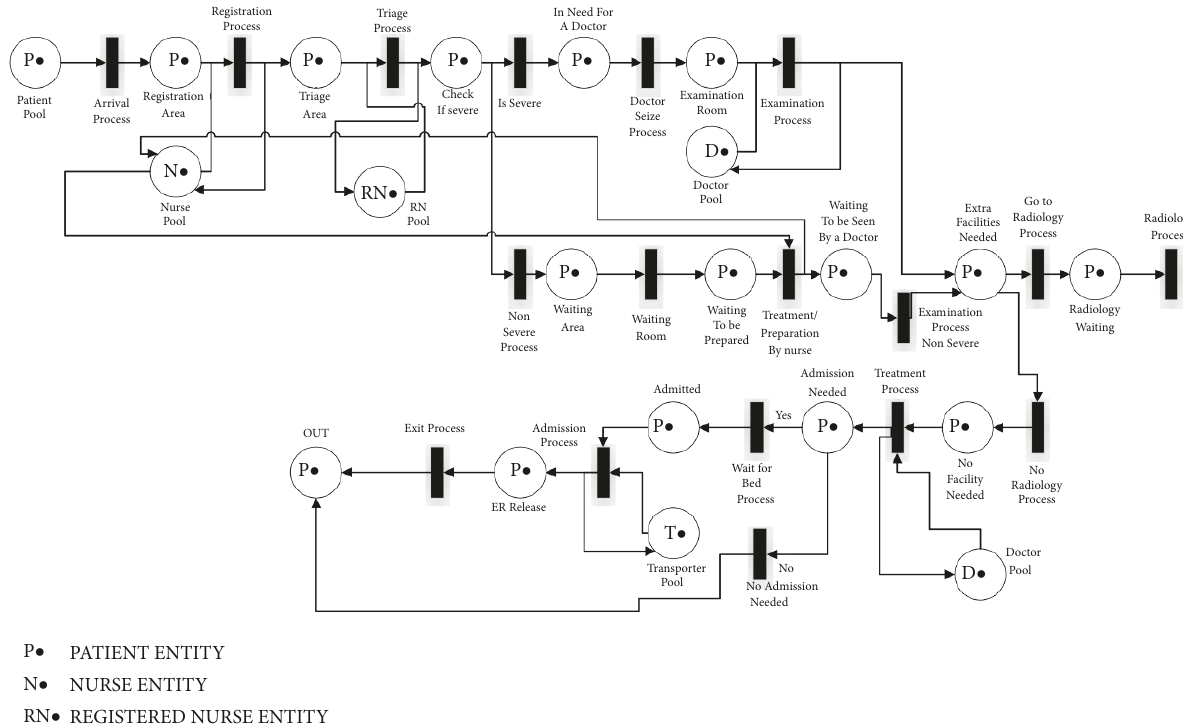
Figure 2: Emergency room